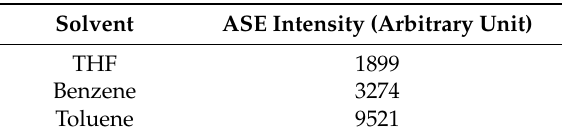
Table 2. Maximum ASE intensity values of conjugated (ADS145UV) polymer in different solvents at 200 µ M, 12